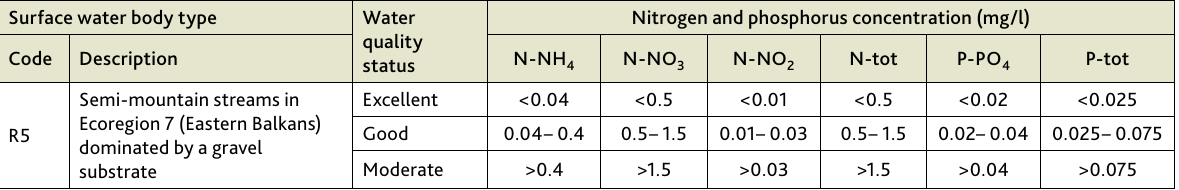
Table 2. Reference threshold values for the concentration of nitrogen and phosphorus compounds in surface water bodies of type R5 as stated in Regulation 4/2012